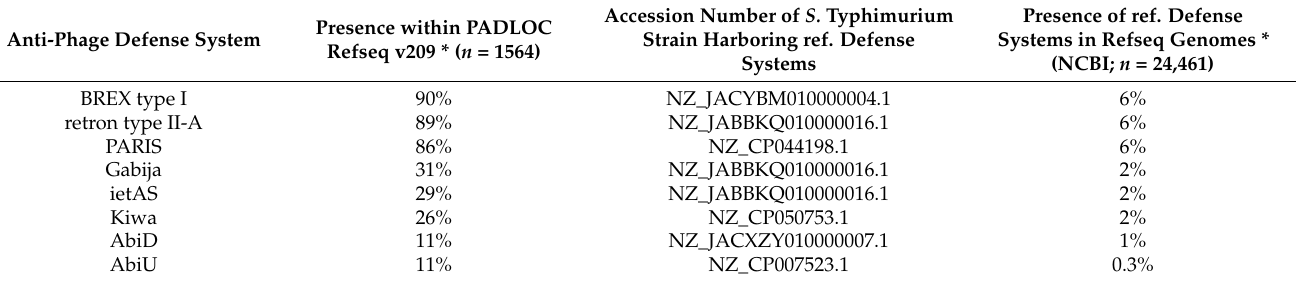
Table 1. Presence of reference defense systems in S.